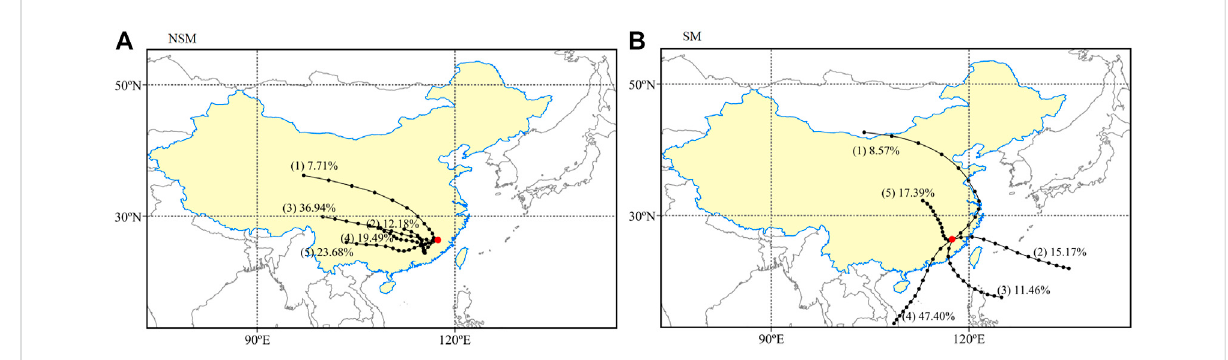
HYSPLIT4 moisture back-trajectory at Sanming from 2019 to 2020, (A) in NSM and (B) in SM. The number in parentheses represents the cluster number and the percentage of this trajectory. The red dots represent the sampling